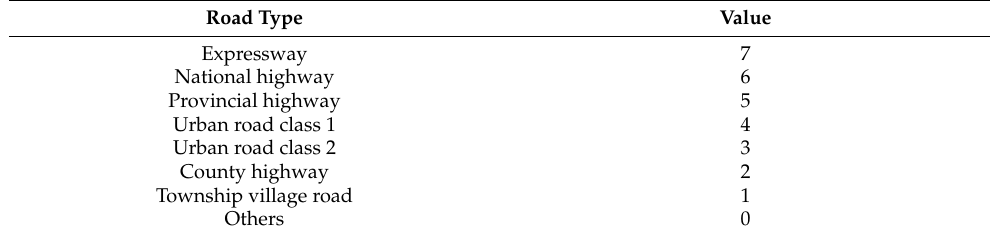
Table 1. The values of road type feature.